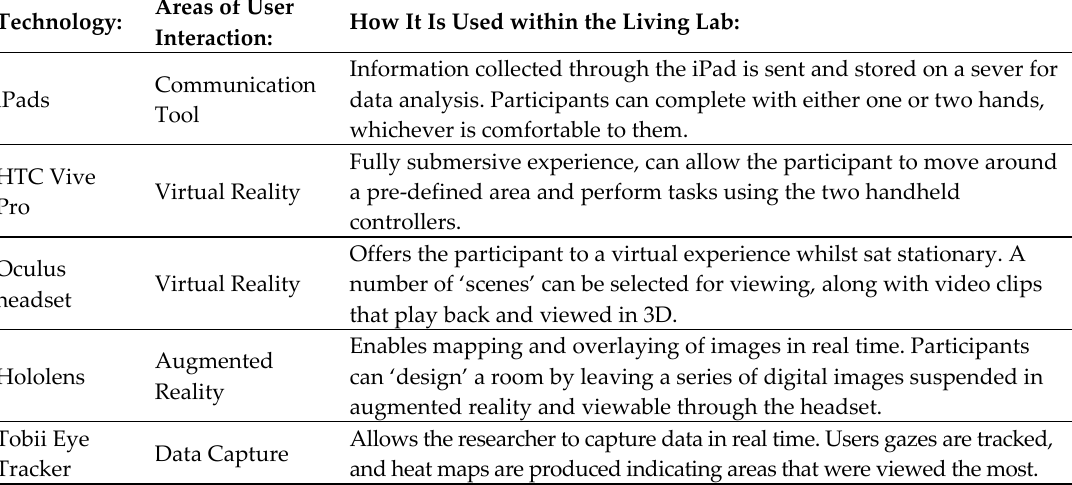
Figure 7. Images of the virtual reality and augmented reality headsets. ( a ) illustrates the VIVE headset and controllers, ( b ) shows the Oculus headset and controller with ( c ) dipicting the Hololens. Table 1. Technology within the living